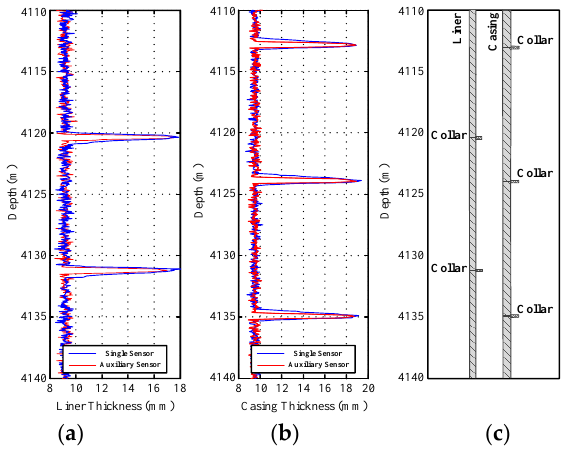
Figure 14. Interpreted thickness using the NDI of two-pipe strings ranging from 4110 to 4140 m: ( a ) liner thickness; ( b ) casing thickness; and ( c ) pipe string structure.